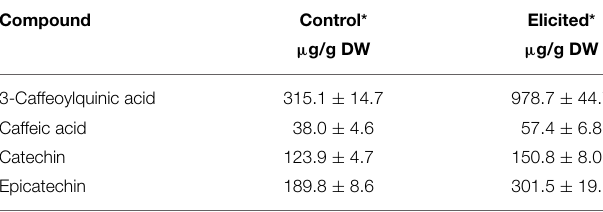
amplification products were analyzed by agarose gel electrophoresis (lane 1 control, lane 2 elicited) stained with ethidium bromide, and visualized by UV transillumination (306nm). An inverse image of the stained gel is shown. (D) Schematic presentation of the RT-PCR results in arbitrary units. The analysis of gene expression is represented in the bar chart using average values of semiquantitative RT-PCR triplicate analysis. The results are relative to non-treated root cultures.